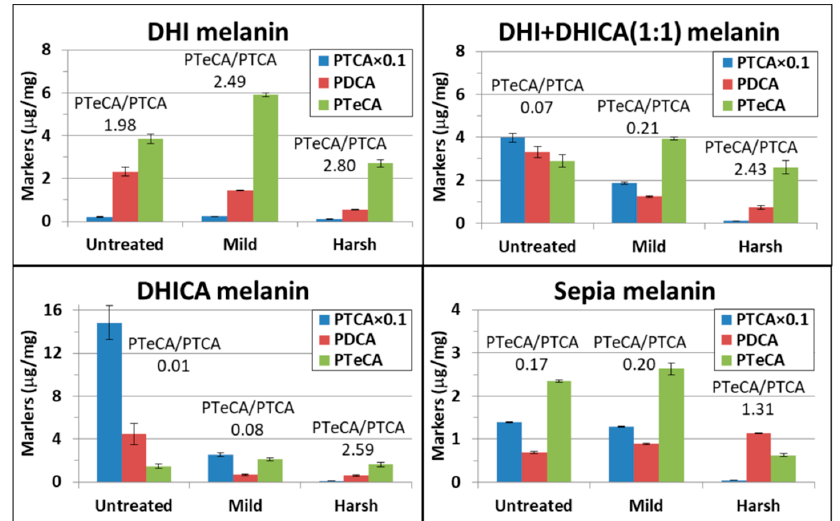
Figure 2. Yields of the eumelanin degradation products upon AHPO in DHI, DHI + DHICA (1:1), DHICA, and Sepia eumelanin after mild (100 °C/100 bar for 24 h) and harsh (250 °C/200 bar for 72 h) treatment, respectively, together with the initial amounts in the corresponding untreated samples. Presented values represent averages ± SD of two independent measurements. For visualization purposes, PTCA values have been scaled down by a factor of 10. For each maturation stage, the PTeCA/PTCA ratio is shown in the graphs.